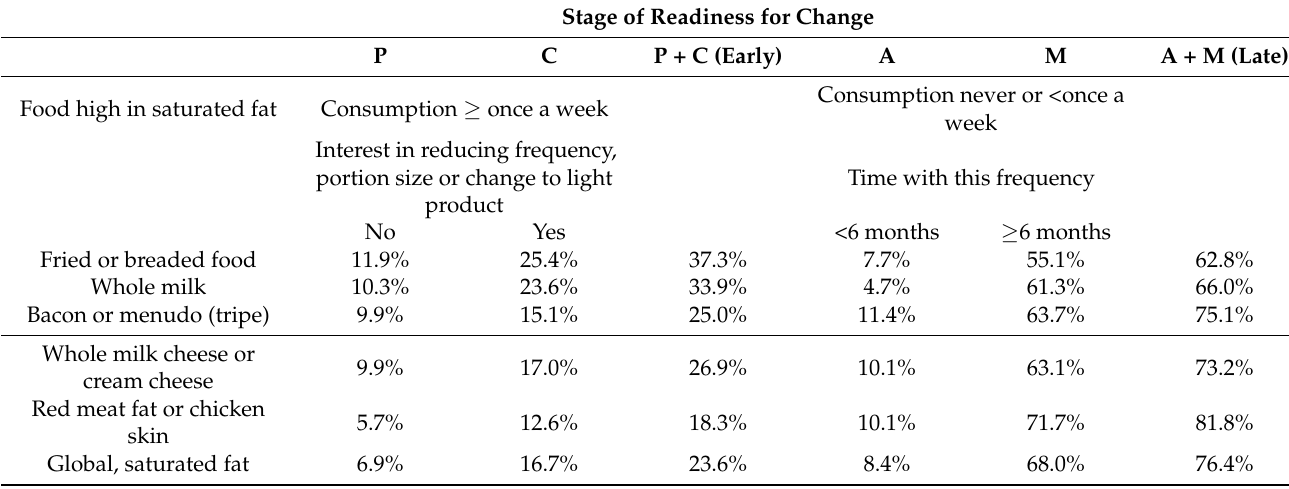
Table 2. Stages of readiness for change in four unhealthy behaviors, patients with type 2 diabetes treated in primary care ( n =